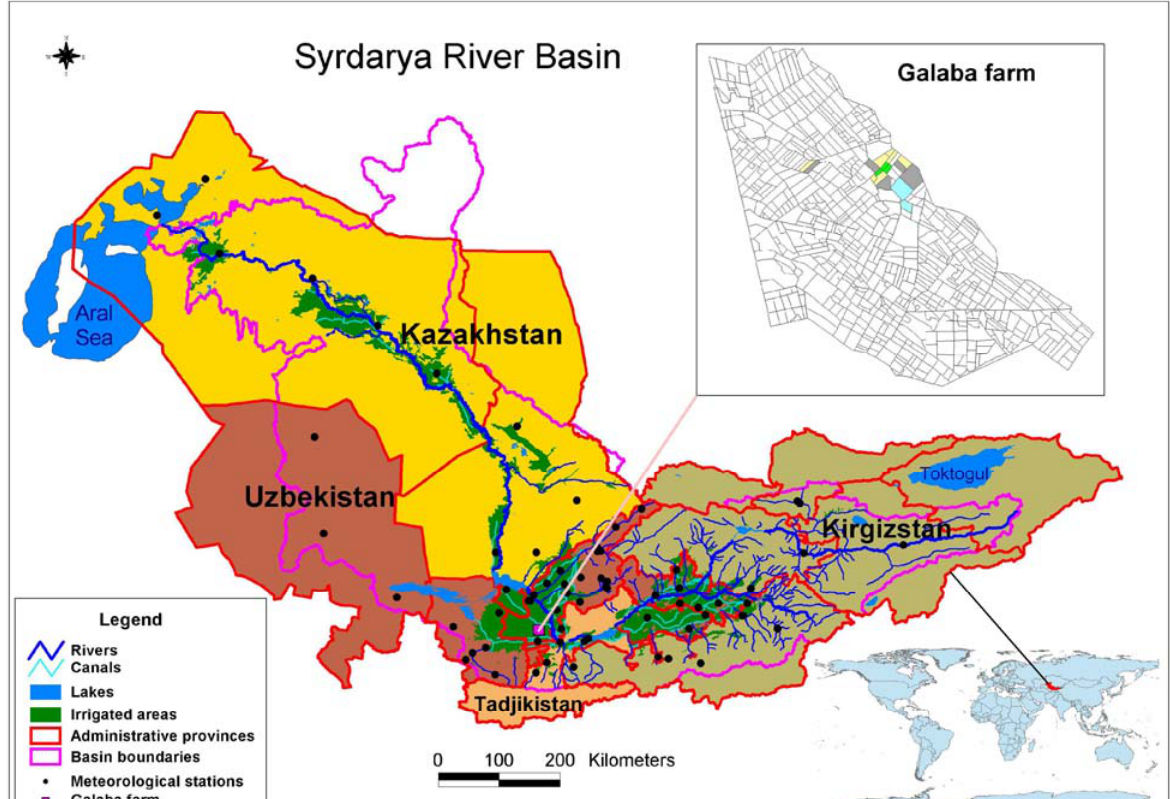
Figure 1. Location of the study